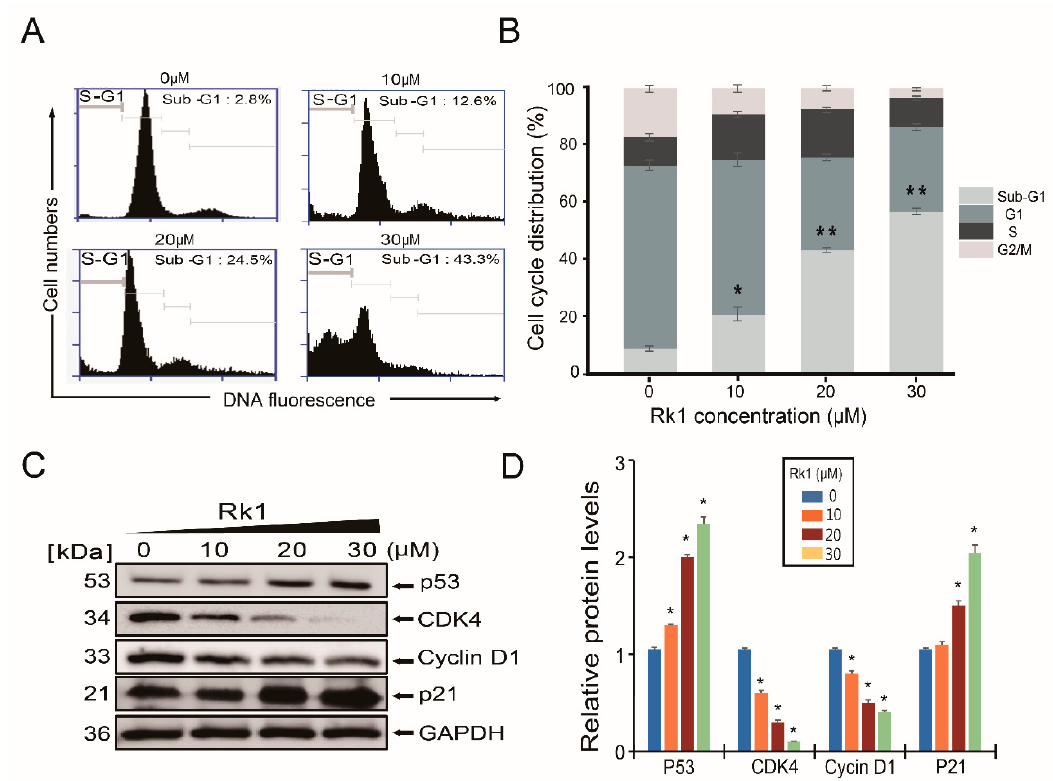
Figure 3. Rk1 blocks cell cycle progression of SK-N-BE(2) cells. ( A , B ) Cell cycle progression was analysed by flow cytometry following staining with PI. S-G1: sub-G1 phase. ( C , D ) The proliferation associated proteins, p21, Cyclin D1, p53 and CDK4 were analysed by western blotting. GAPDH was used as a protein loading control. Data are in ( B , D ) represented as mean ± SD three independent experiments. * p < 0.05 and ** p < 0.01 versus control. CDK4, cyclin dependent kinase-4.